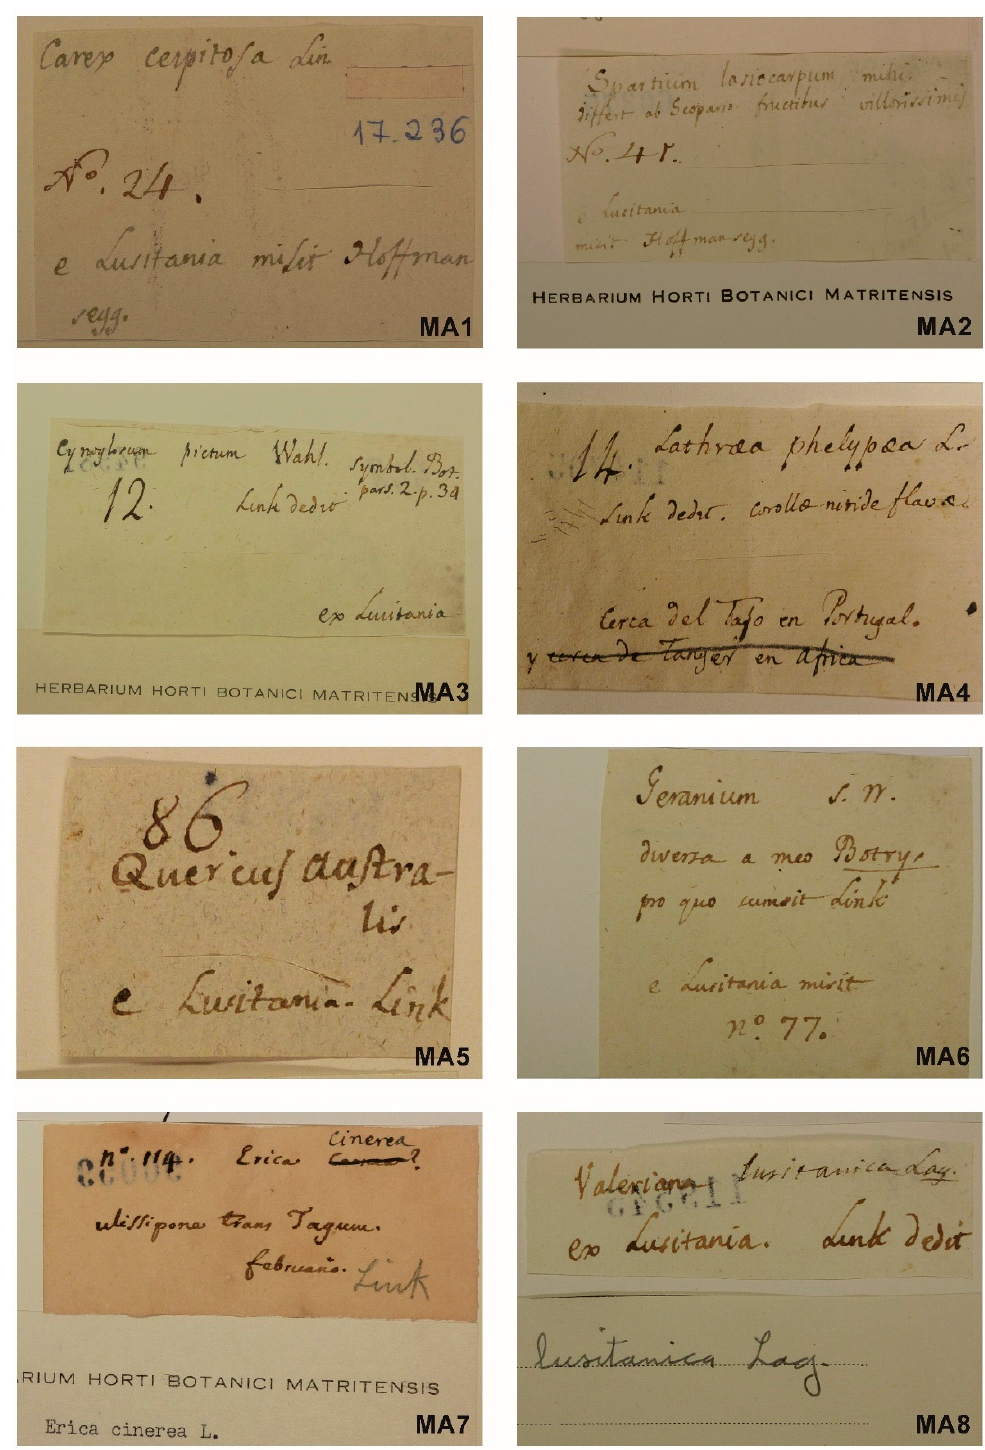
Figure 2. Examples of labels in the specimens of Hoffmannsegg and Link in the Herbarium MA: MA1 (MA017236) and MA2 (MA060375) from specimens sent by Hoffmannsegg. MA3 (MA094981), MA4 (MA094981), MA5 (MA114705) and MA6 (MA054711) from specimens sent by Link. MA7 (MA090059) and MA8 (MA119545) are from specimens sent by link but not in the letters [43–50] in the archive of the Real Jardín Botánico of Madrid.